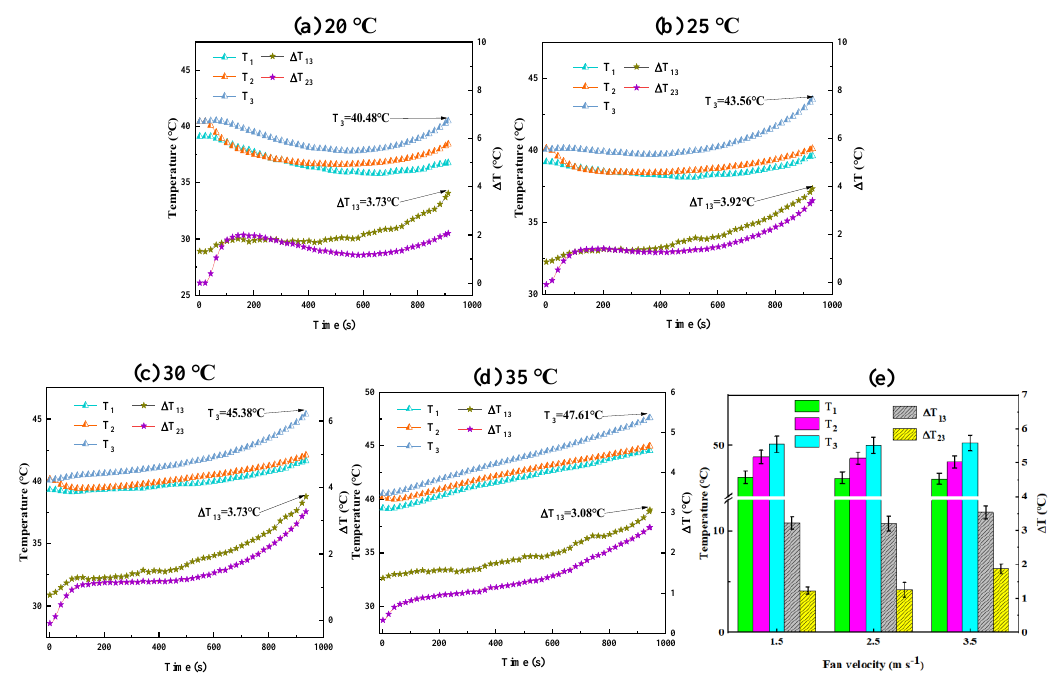
Figure 7. Temperature and ΔT variation curves of the CPCM-liquid module with different inlet water temperatures of ( a ) 20 °C, ( b ) 25 °C, ( c ) 30 °C and ( d ) 35 °C; ( e ) Comparison of the testing results at the termination of discharge.